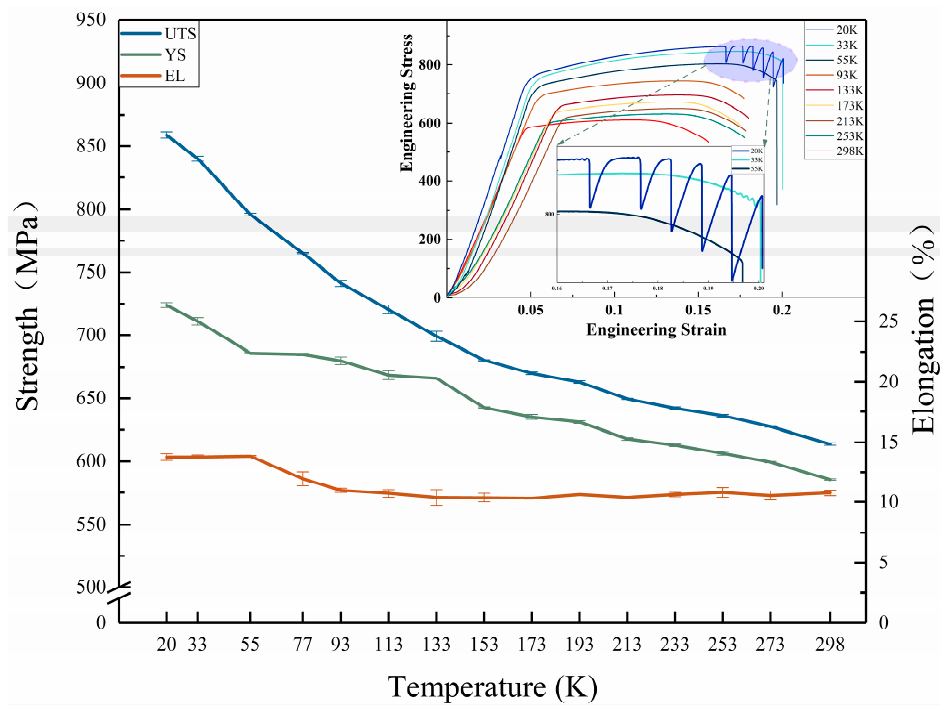
Figure 3. Uniaxial tensile behavior and stress–strain curves of the 2195-T8 alloy at di ff erent temper- atures.